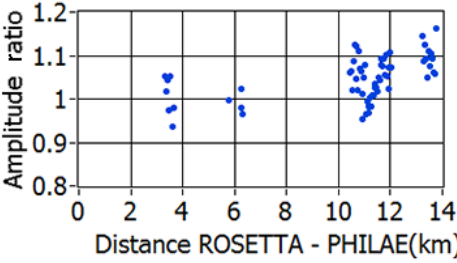
Figure 10. The ratio of the ROMAP/RPCMAG magnetic field am- plitudes (from Fig. 9) plotted versus orbiter-lander distance.